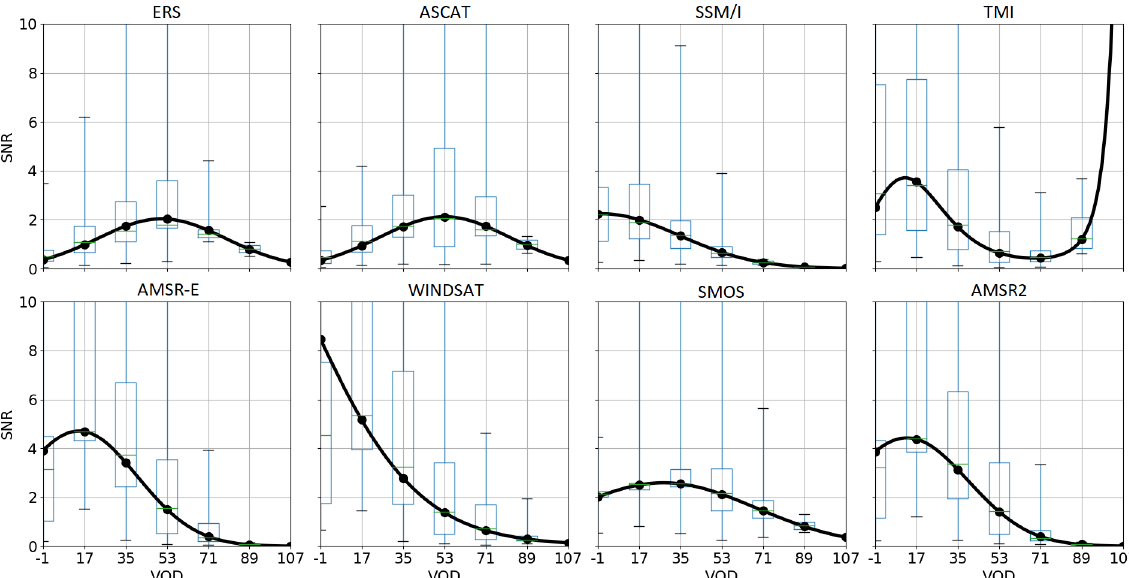
Figure 6. Regression functions between VOD and SNRs (in decibel units) of all L2 products. Box plots show the median, the interquartile range and the 5 and 95 percentiles, respectively.